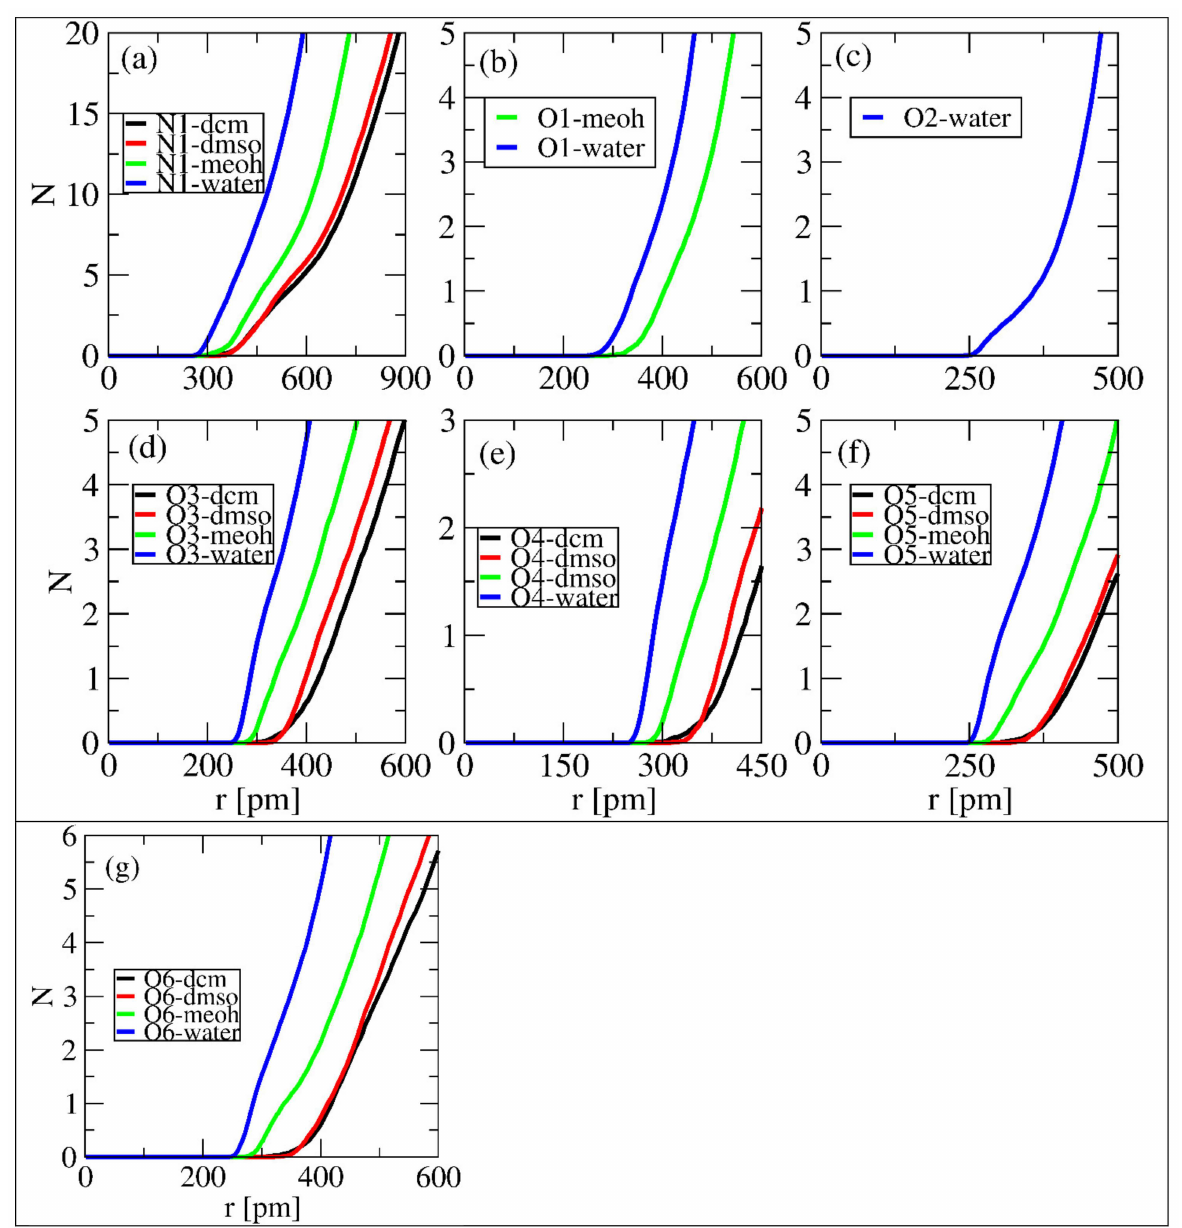
Figure 7. Number of solvent molecules in the first solvation shell for selected sites of linamarin